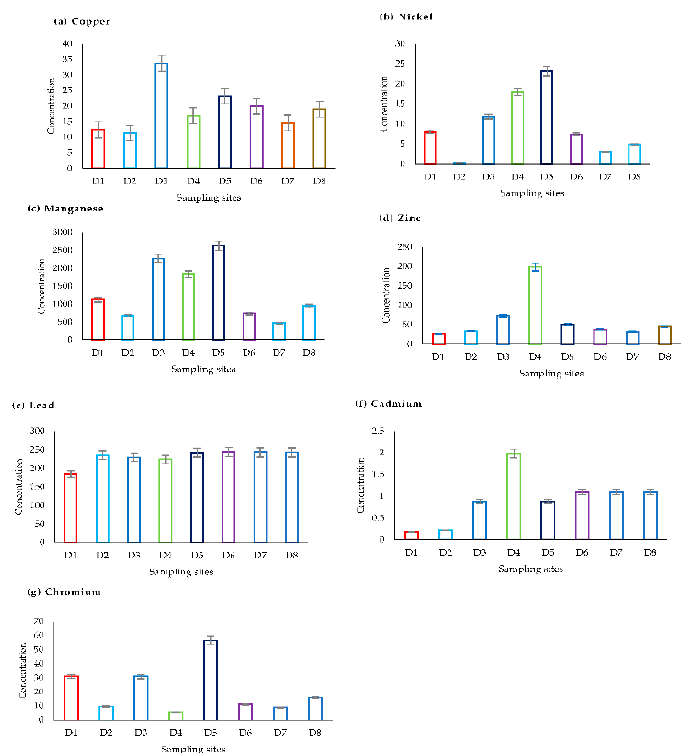
Figure 2. Concentration of potentially ecotoxic elements (mg kg − 1 ) in dust samples from urban roads, highways and pedestrian bridges in Eastern Uganda. Sampling sites are: D1 = Bushika bridge crossing from Bubulo to Busiu; D2 = Roadside of Bushika bridge at the junction with Bududa–Manafwa road; D3 = Zikoye–Bushika road but within the Bubulo bridge; D4 = Junction of Zikoye–Bushika and Bududa–Manafwa roads of Bubulo bridge; D5 = Manafwa town (Bududa–Manafwa highway); D6 = Bududa town (Bududa–Manafwa highway); D7 = Manafwa bridge (Mbale–Tororo